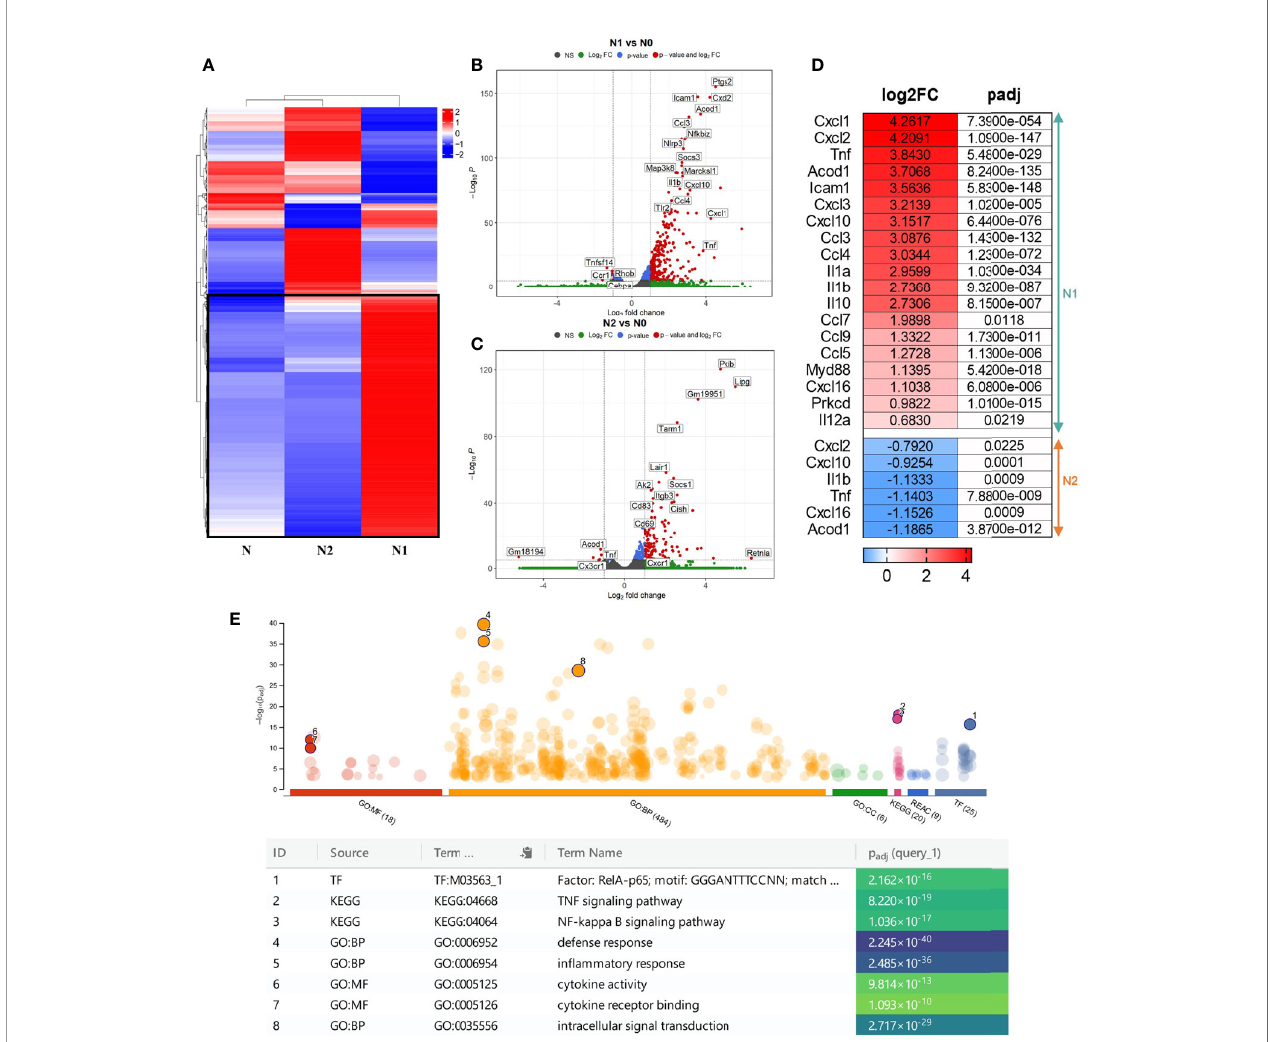
FIGURE 1 | Gene expression pro fi ling of the different neutrophil subsets. (A) Hierarchical Clustering Heatmap analysis of N, N1, and N2 neutrophils. Hierarchical clustering analysis was conducted of log2(FPKM+1) of differential expression genes union within all comparison groups. The color coding indicates different levels of expression: red indicates genes with high expression, and blue indicates genes with low expression levels. A major cluster of DEGs up-regulated in N1 is highlighted in a black square. (B, C) Volcano plot of differential gene expression between N1/N2 and N cells. The red dots represent signi fi cantly up-regulated and down-regulated genes with – adjP < 0.05 and Log2FC > 1: 771 genes were up-regulated and 195 genes were down-regulated in N1 vs N neutrophils; 532 genes were up-regulated and 124 genes were down-regulated in N2 vs N cells. (D) Heatmap showing log2 Fold change and adjusted p-value for selected in fl ammatory cytokines and chemokines differentially expressed either in N1 (upper panel) or N2 neutrophils (lower panel). Red color indicates the up-regulated, and blue the down-regulated genes. (E) Manhattan plot illustrating the results of the enrichment analysis of the gene cluster of highly up-regulated genes in N1 compared with N and N2 neutrophils. The functional terms are grouped and color-coded by data sources, i.e., molecular function (MF) in red, biological processes (BP) in orange, cellular components (CC) in green, KEGG in pink and TRANSFAC in dark blue. Numbered terms are detailed below the plot with their respective adjP